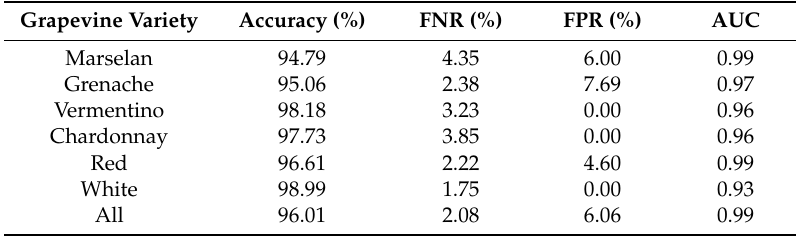
Table 4. Results of using complete spectra in classifying different groups of spectral data acquired in the September acquisition campaign (Severity of infestation = 2).